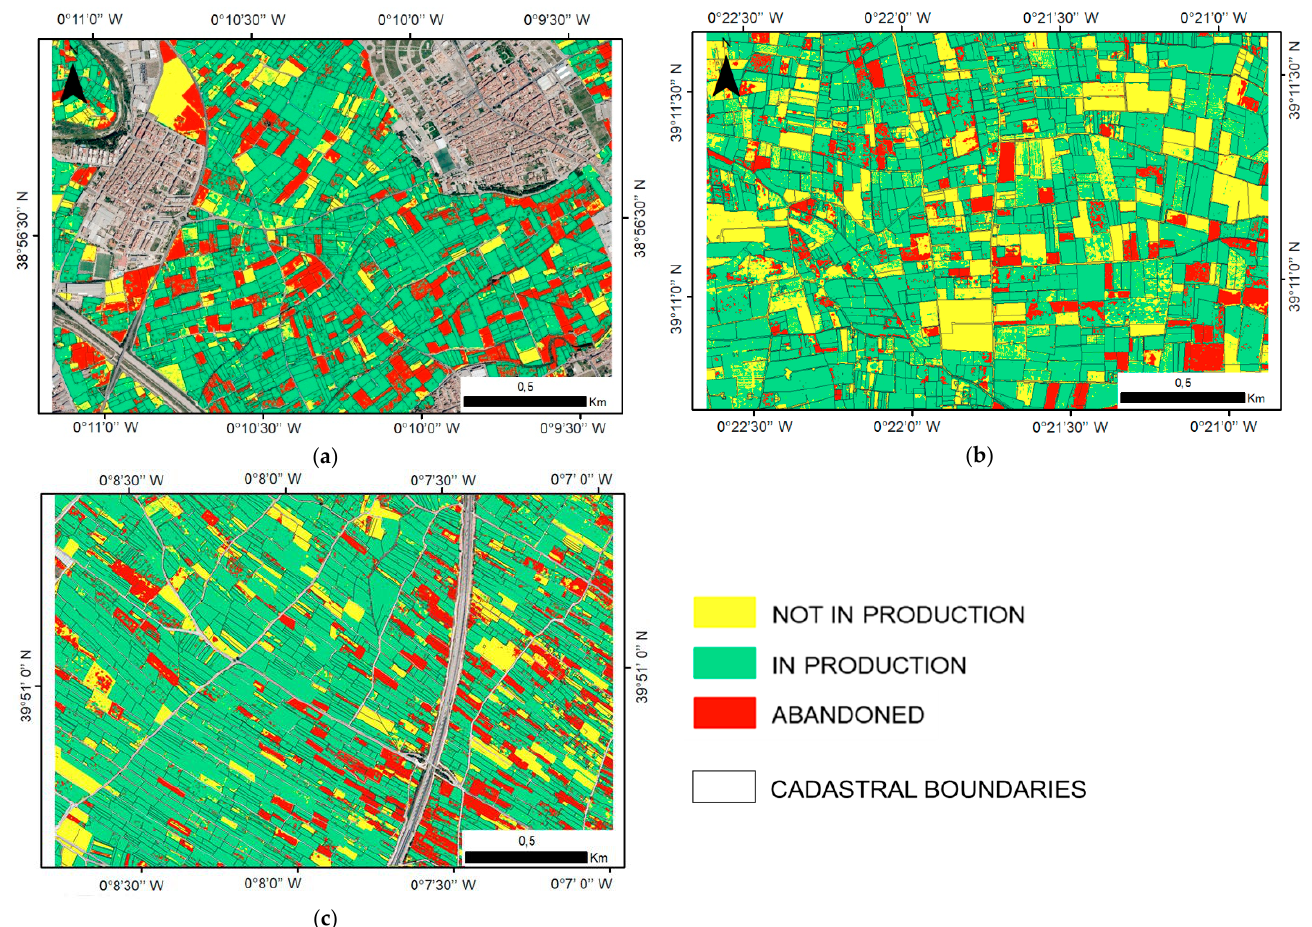
Figure 7. Land abandonment map obtained in the complementary areas: ( a ) Bellreguard / Almoines, ( b ) Benicull / Polinyà del Xuquer, ( c ) Nules.